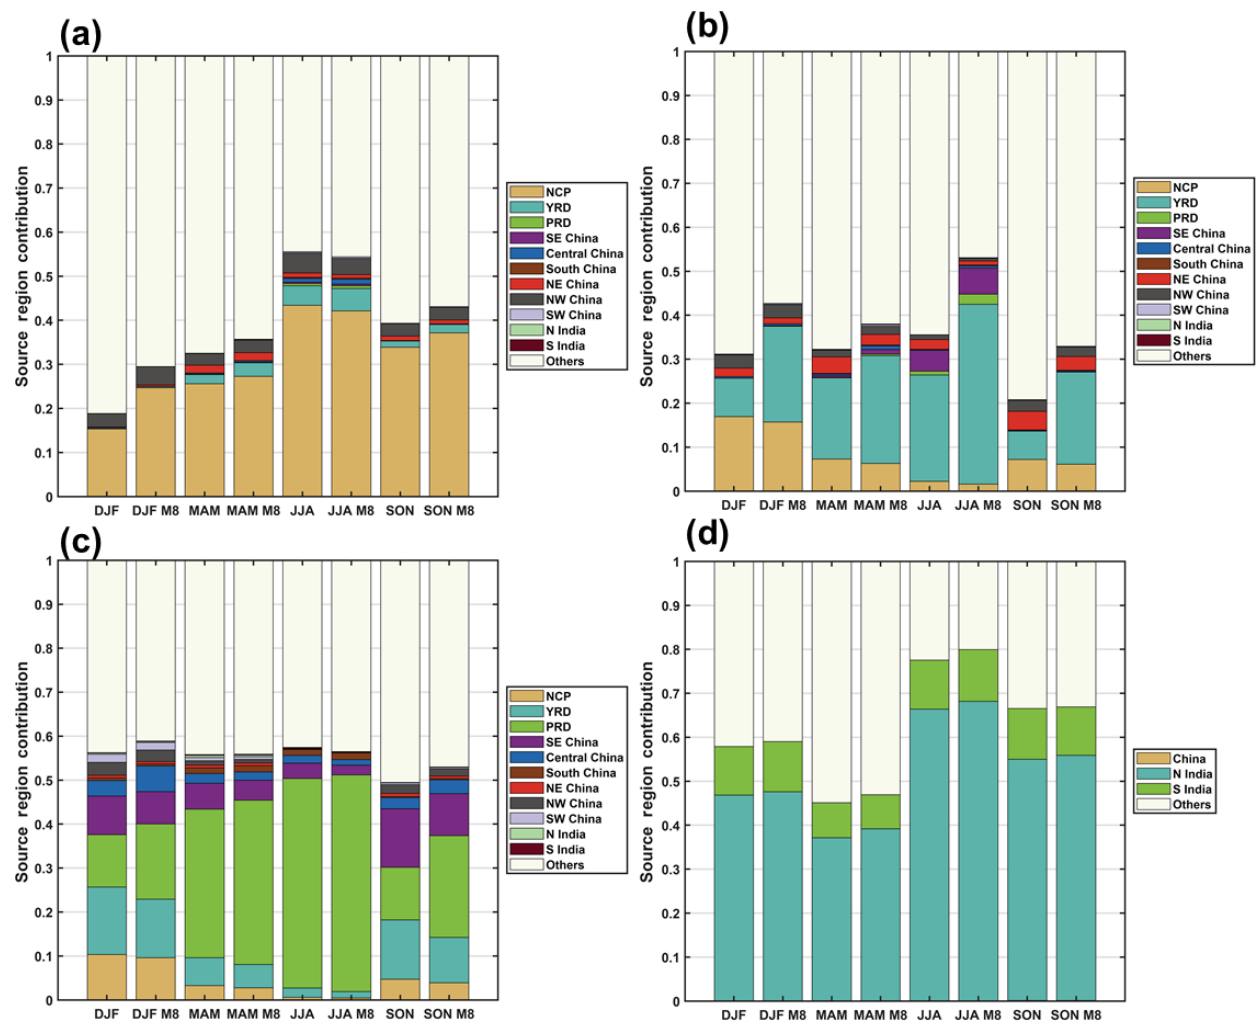
Figure 8. Contributions to seasonally daily mean ozone (DJF, MAM, JJA, and SON) and MDA8 ozone (DJF M8, MAM M8, JJA M8, and SON M8) in Beijing (a) , Shanghai (b) , Guangzhou (c) , and New Delhi (d) from different source